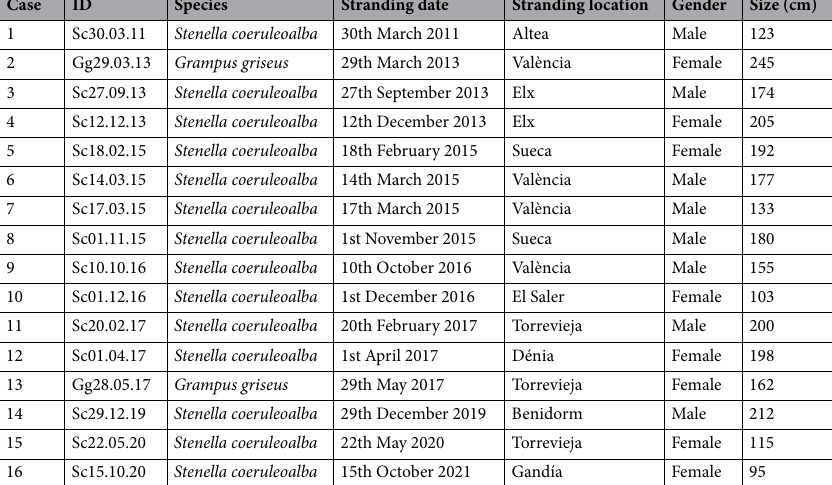
Table 1. Summary information for 16 dolphins that stranded on the coastline of the Valencian Community, Spain and were suspected to have suffered from inter-specific interactions with bottlenose dolphins. Size (total length) was measured from tip of upper jaw to fluke